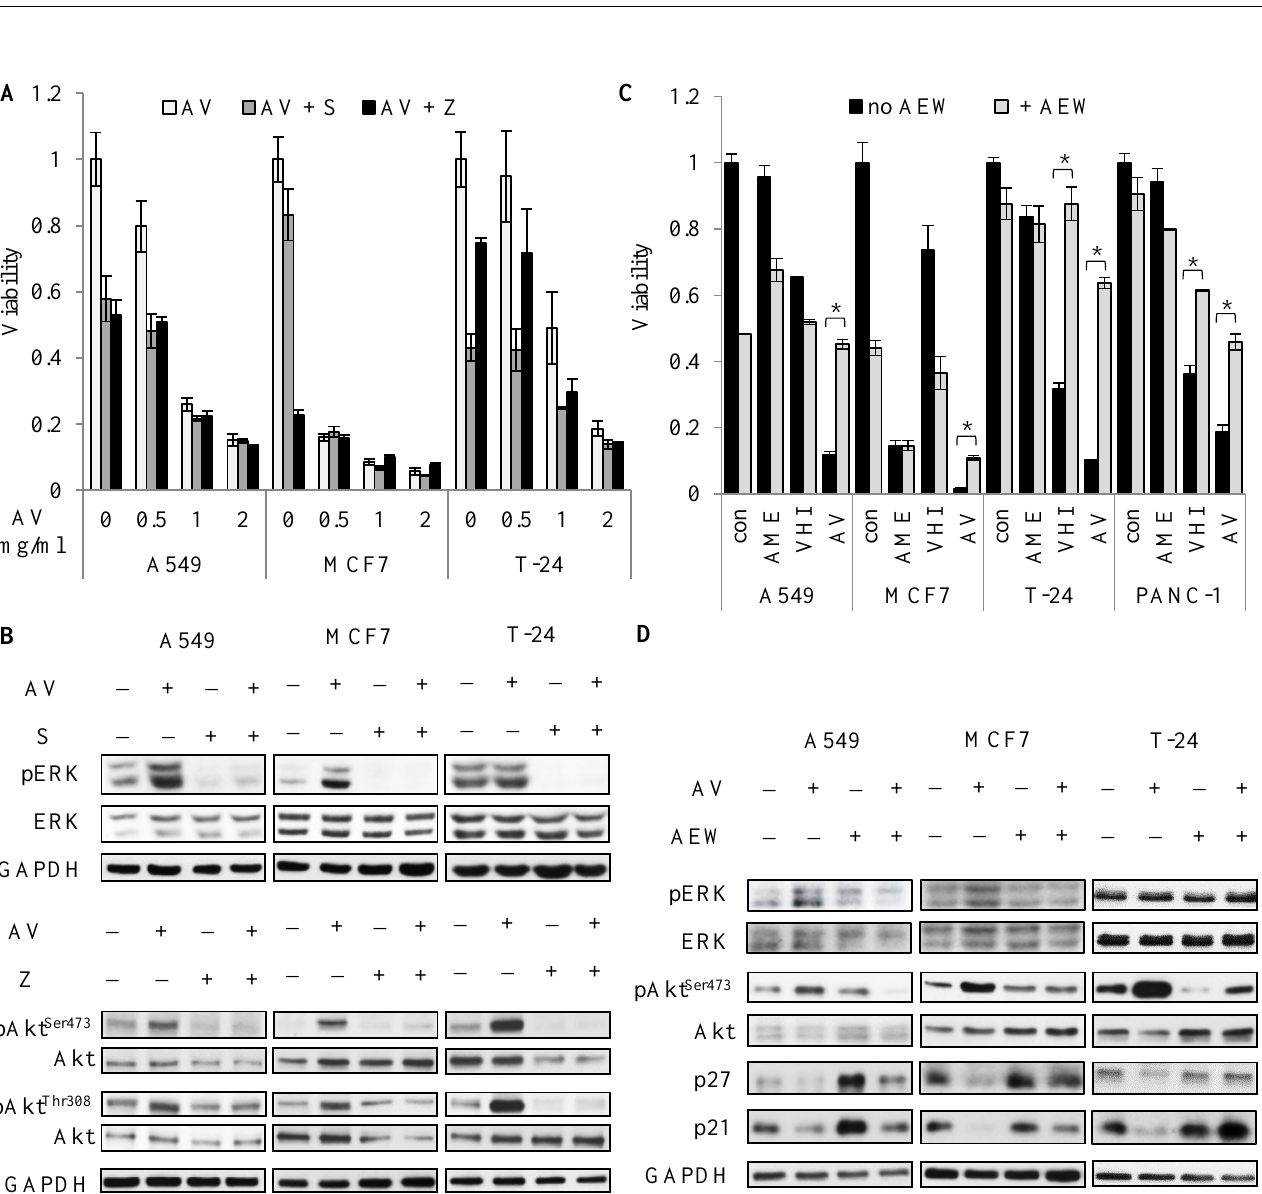
Figure 5. Influence of MEK1/2, PI3K and IGF1-R inhibitors on AV’s effect. ( A ) Viability of cells treated with AV for 72 h in the presence or absence of 2 mM Selumetinib (“S”, MEK1/2 inhibitor) or 1 mM ZSTK-740 (“Z”, PI3K inhibitor). ( B ) WB of cells treated with 2 mg/mL AV with or without 2 mM Selumetinib or 1 mM ZSTK-740 for 24 h. ( C ) Viability of cells treated for 72 h with 2 mg/mL of AME/VHI/AV with or without 1 µ M AEW541. ( D ) Western blot of cells treated for 24 h similarly to ( C ). *— p -value < 0.001. S – Selumetinib; Z - ZSTK-740; AEW -